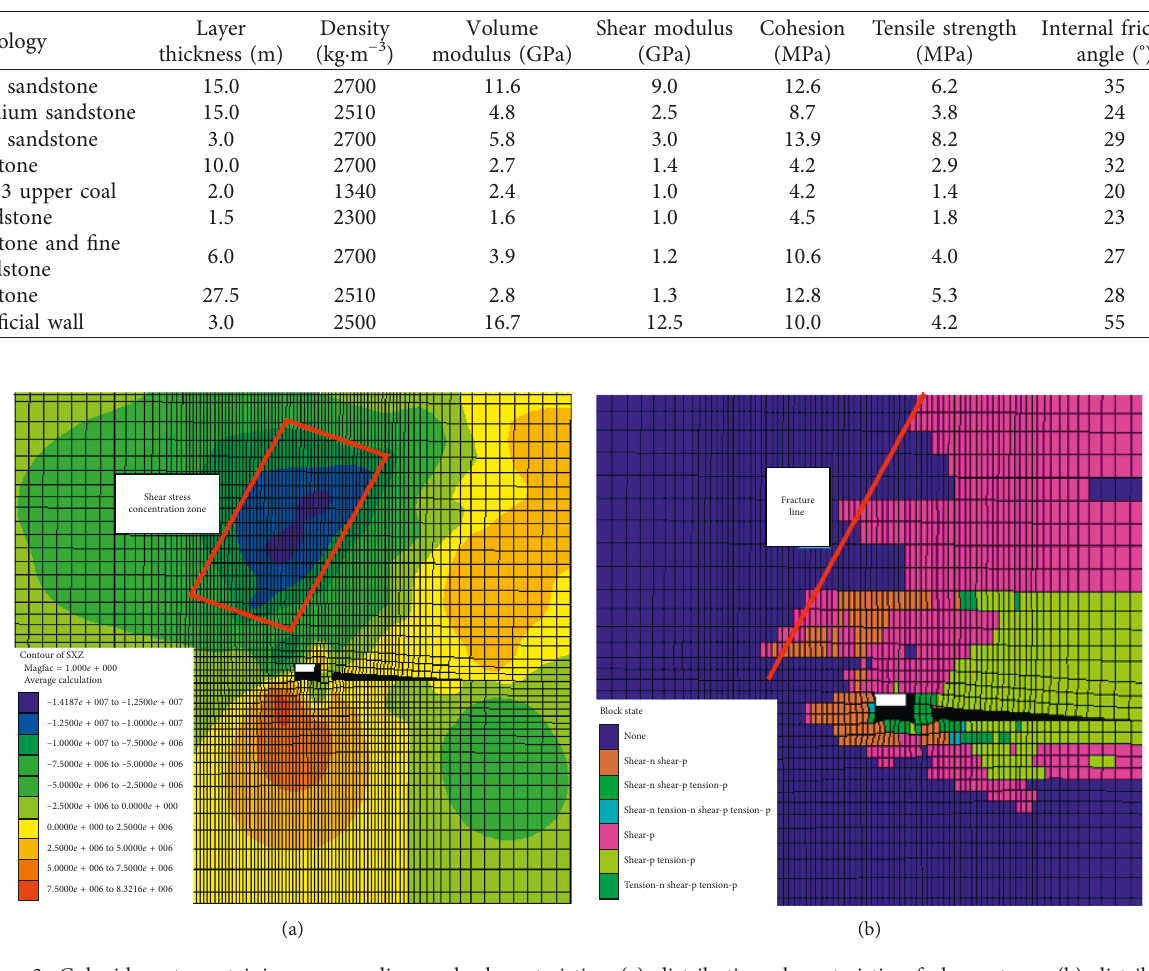
Table 1: The rock mechanics parameters of the numerical simulation model.